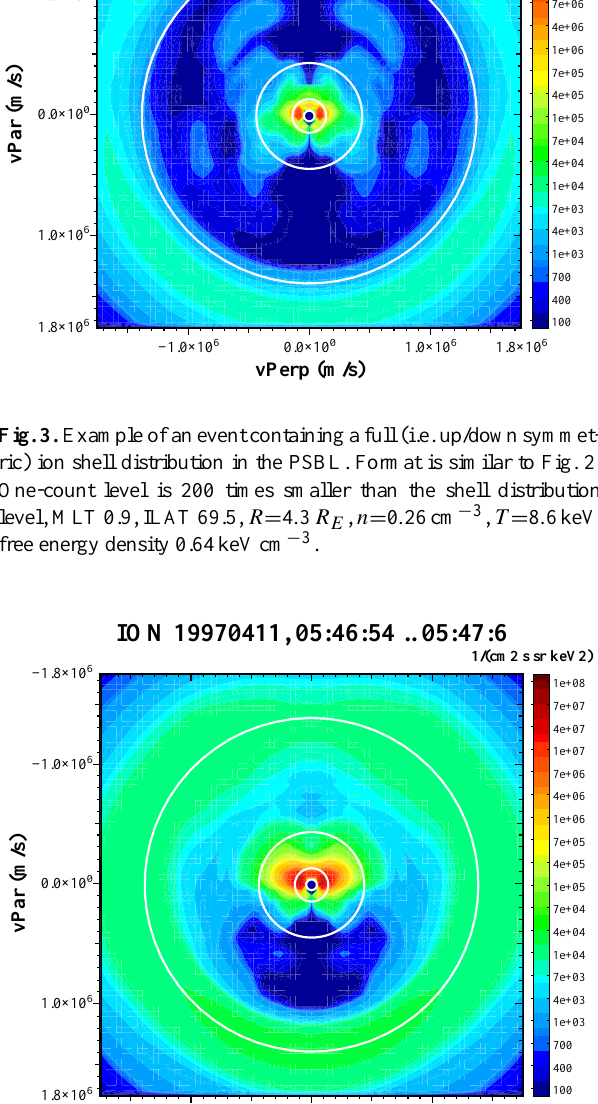
light regions (CPS and BPS) moves with K p very similarly to the statistical oval equatorward boundary (dashed line). Oth- erwise, the energy densities increase with K p overall. In the PSBL, the free energy density is somewhat higher for high K p and it is spread more uniformly over the MLT